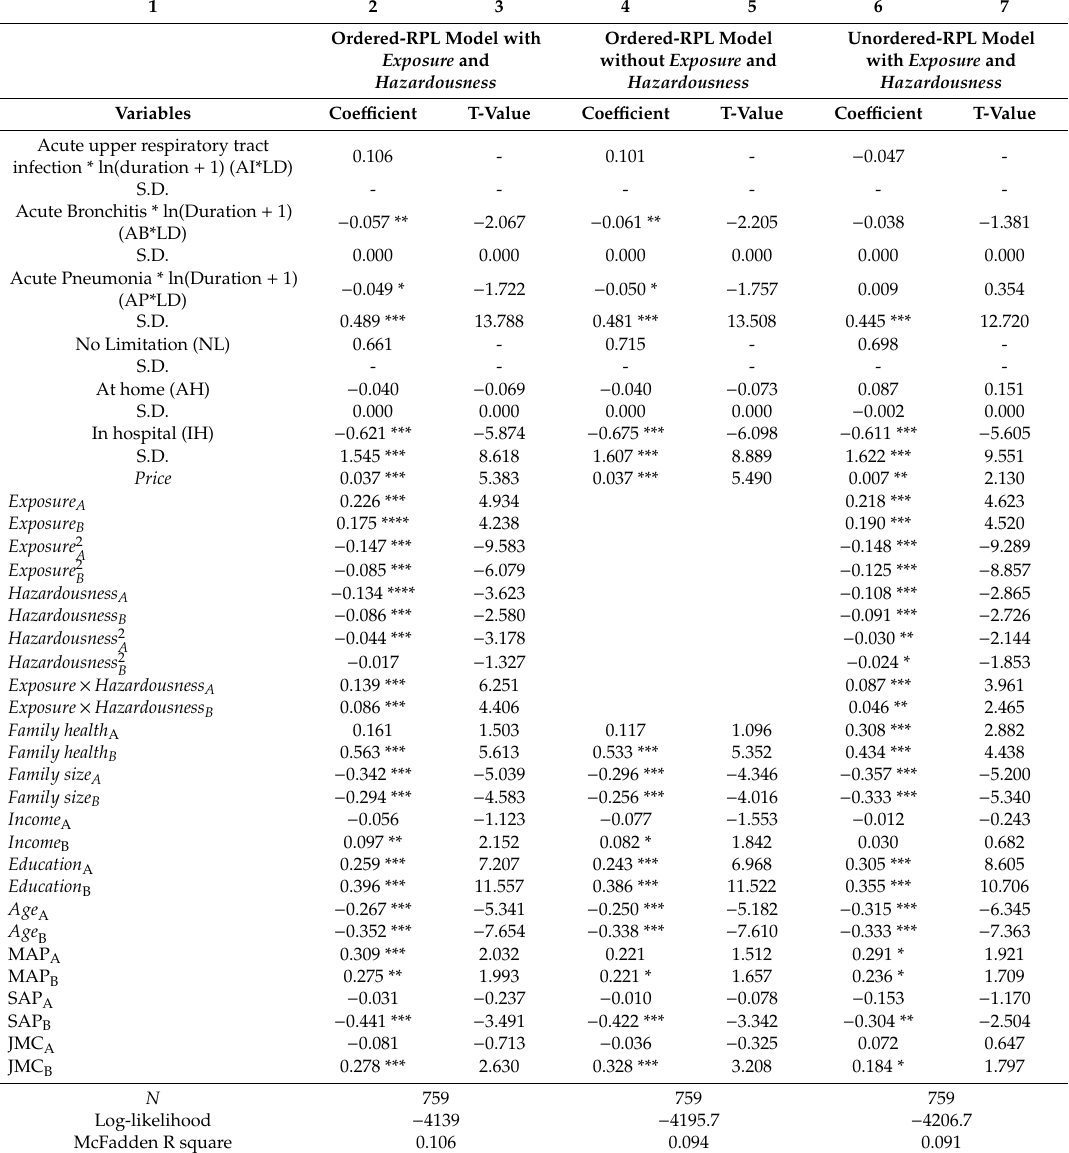
Table 4. The estimated RPL